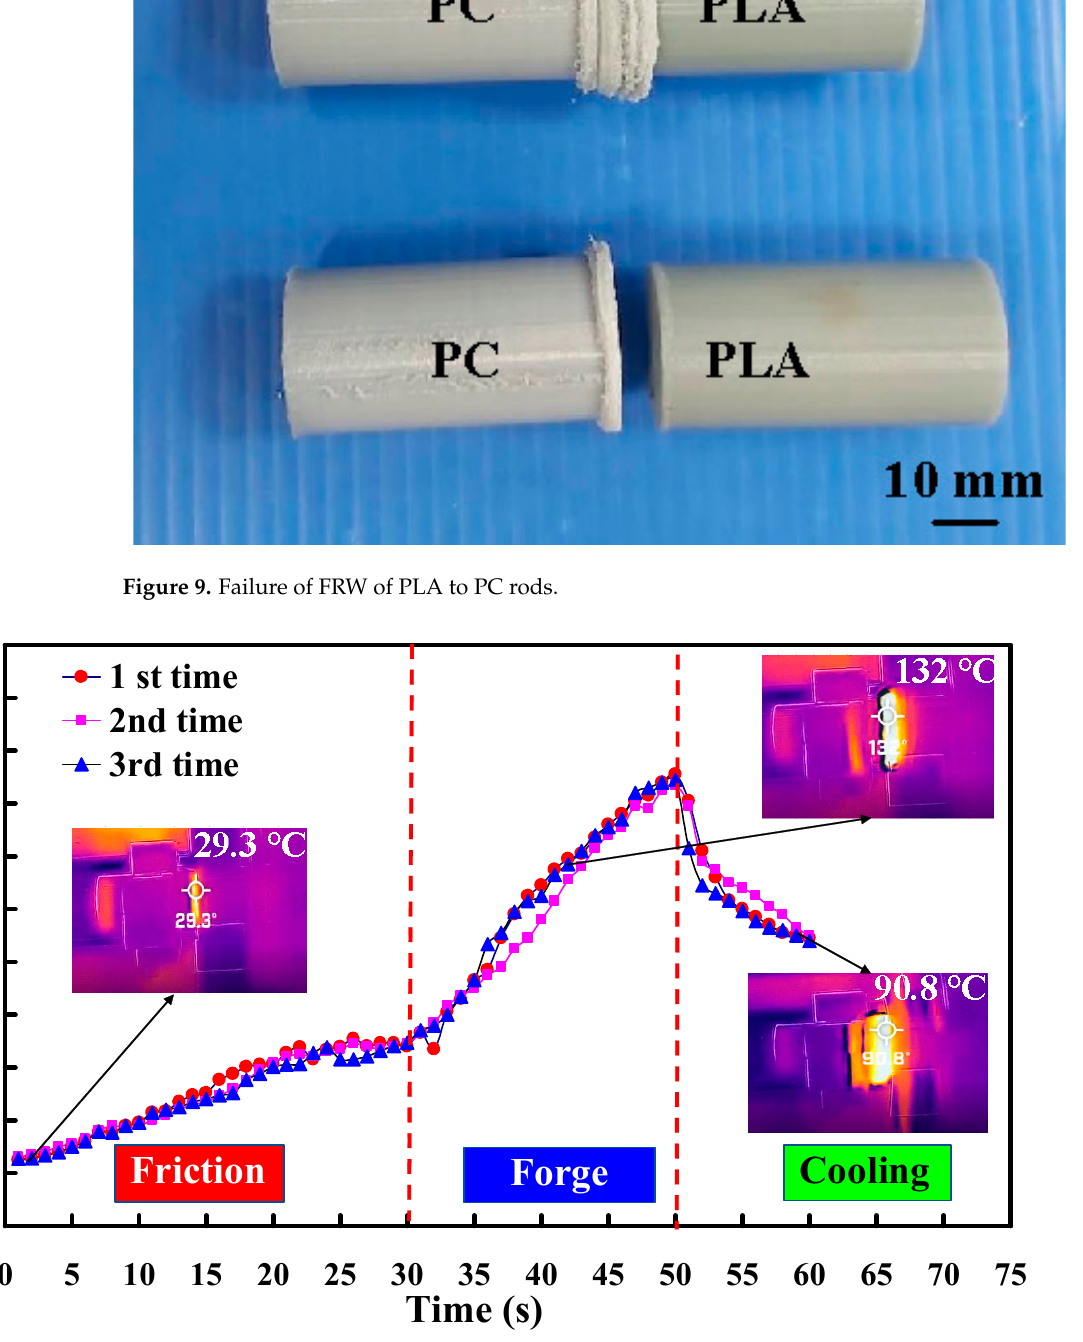
Figure 10. WI temperature as a function of welding time for the PLA to ABS rods in repeated exper- iments.